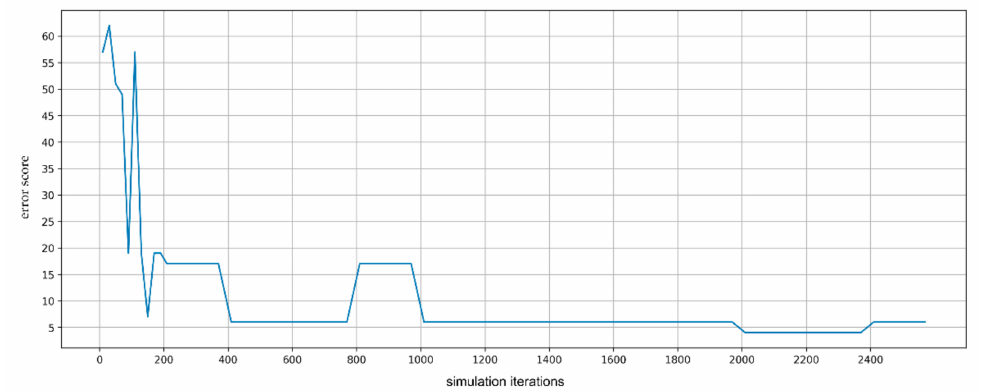
Figure 7. Overall stability error of the distribution method with respect to the number of simulation iterations.